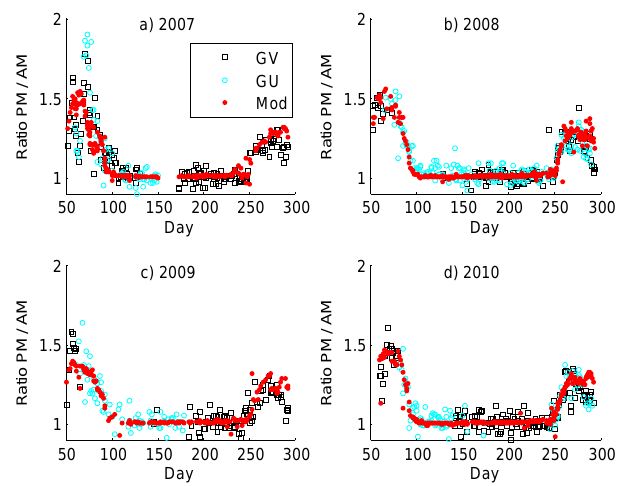
Fig. 4. Ratio of evening twilight to morning twilight NO 2 as mea- sured by the GBS-vis (black squares) and GBS-UV (blue circles) and as calculated using a photochemical model (red dots). Ratios are plotted against day of year for (a) 2007, (b) 2008, (c) 2009, and (d)